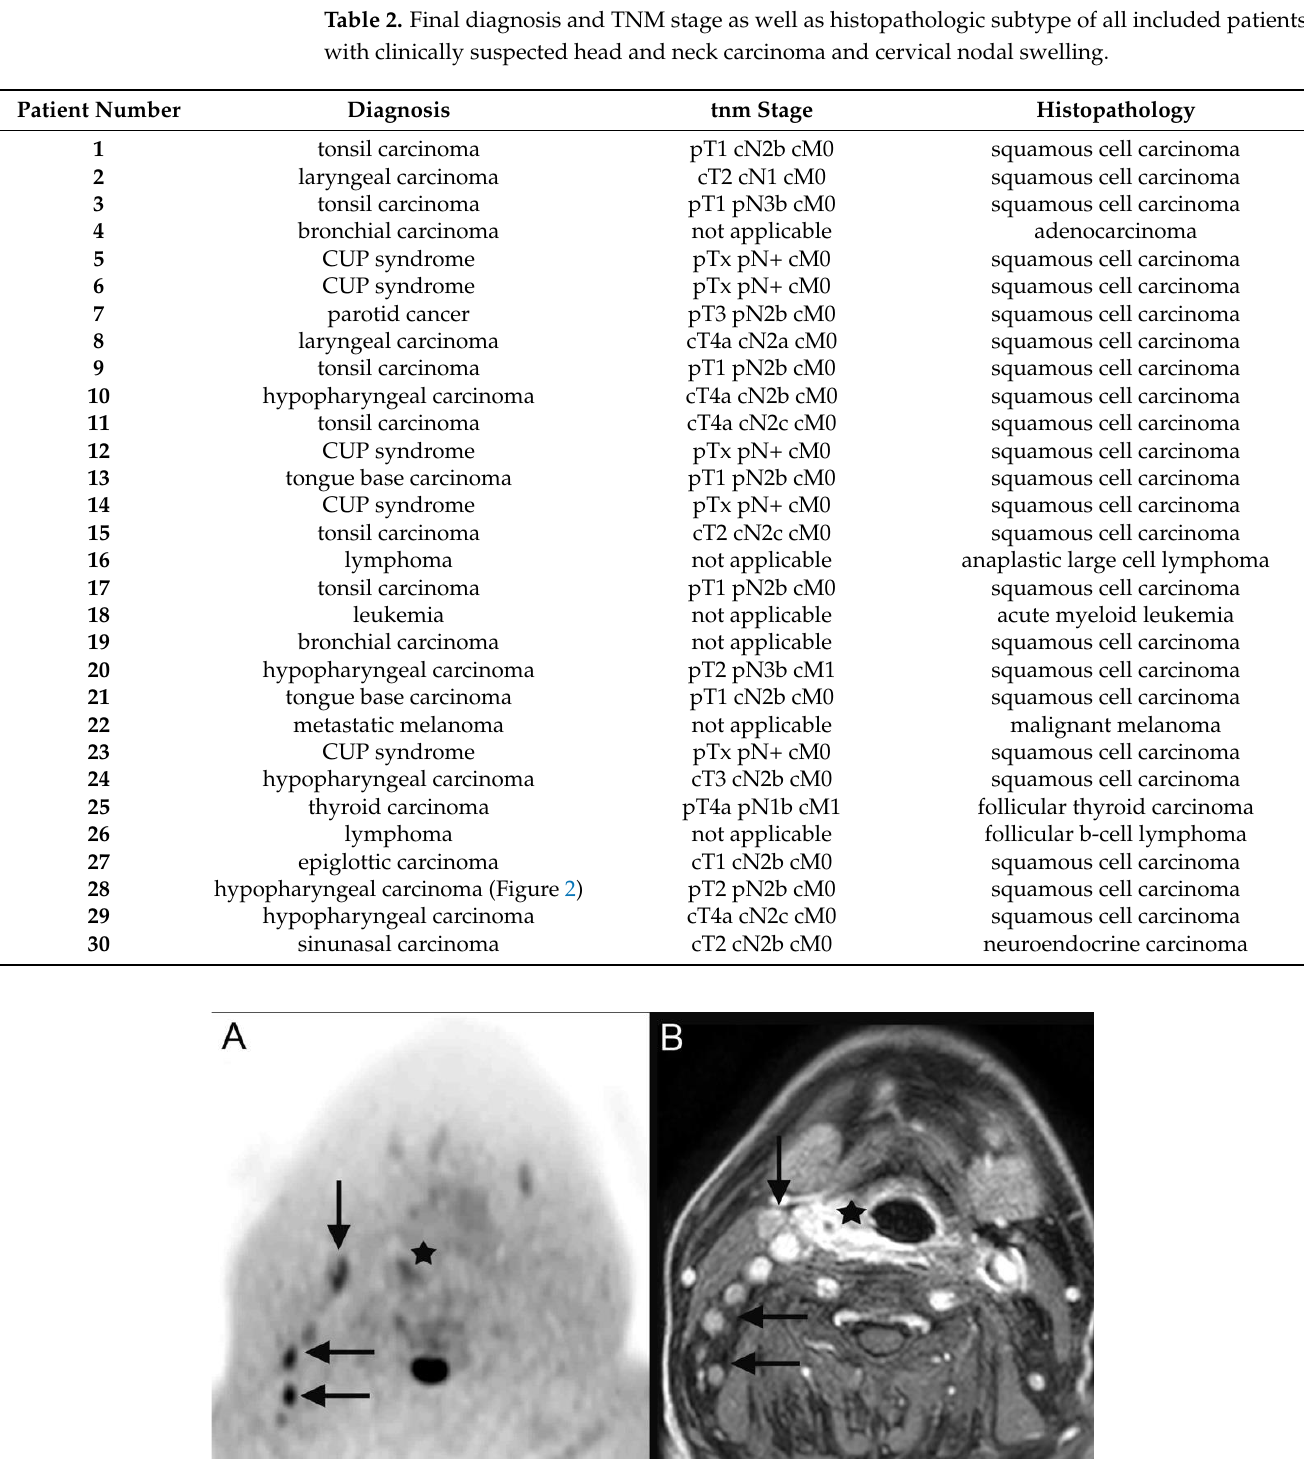
Figure 2. DWIBS ( A ) as well as contrast-enhanced fat-saturated T1-weighted MR images ( B ) depict the primary cancer ( A , B : black star) lesion as well as the nodal metastasis ( A , B : black arrows) in a 70-year-old male patient who was diagnosed with a right-sided hypopharyngeal carcinoma (cT2 cN2b cM0).